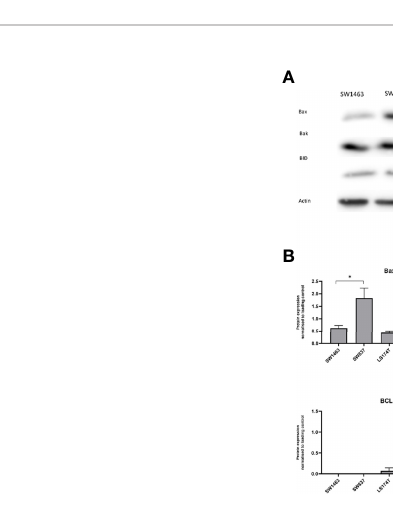
pathway (pro-Caspase-8) in our mucinous and non-mucinous cell lines ( Figure 3 ). No signi fi cant difference was observed in the protein levels of pro-Caspase 9 or pro-Caspase 8 between mucinous and non-mucinous colorectal cancer cell lines. Levels of pro-Caspase-3 were also not changed in our cell lines. Collectively, these observations suggested alterations particularly in the control of the mitochondrial apoptosis pathway by Bcl-2 family proteins in mucinous cancer cells.